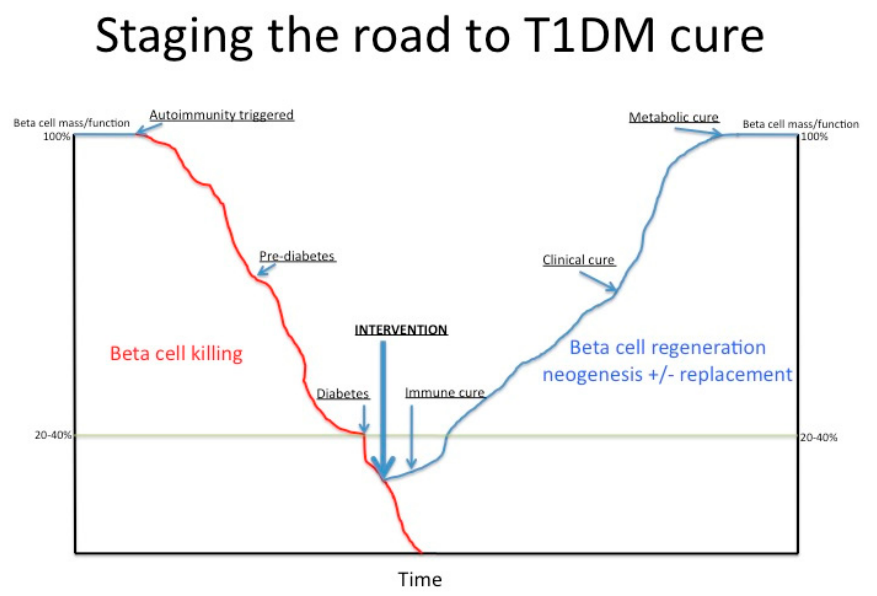
Figure 1. The road to clinical type 1 diabetes (T1DM) [7] and stages of recovery from the disease.